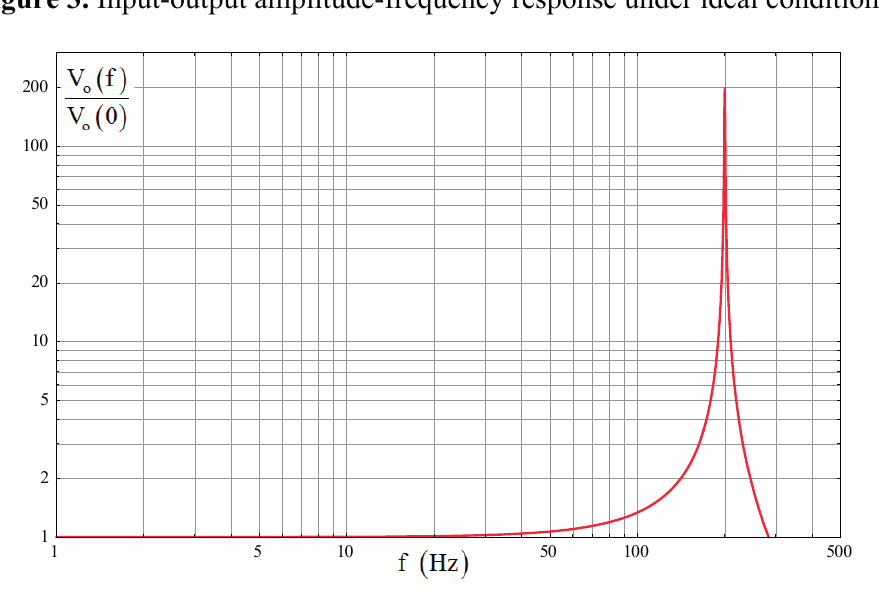
Figure 3. Input-output amplitude-frequency response under ideal